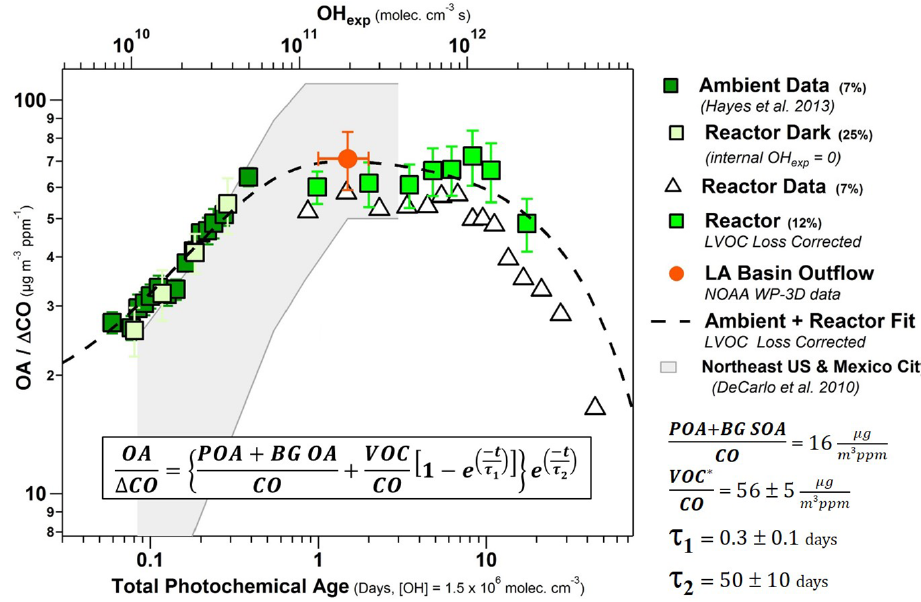
Figure 9. Ratio of OA to excess carbon monoxide (above background levels) vs. total photochemical age in days (at OH = 1 . 5 × 10 6 molec.cm − 3 ) for ambient and reactor data, with vertical error bars indicating standard errors. Also shown in the value for LA Basin out- flow from aircraft measurements from the NOAA WP-3D during CalNex (Bahreini et al., 2012b). See Hayes et al. (2013) for a discussion of the determination of CO background levels. Averages for quantiles of ambient (7%), reactor (7%), reactor dark (25%, internal OH exp = 0), and reactor vapor loss-corrected (12%) data are shown. A fit to reactor data is also shown, including background (BG) SOA and primary organic aerosol (POA; see text for details). Results from field studies in the northeastern USA and Mexico City are shown in the background (DeCarlo et al., 2010). Note that the LVOC loss correction can only be applied when reactor output OA is larger than ambient OA, which reduces the number of data